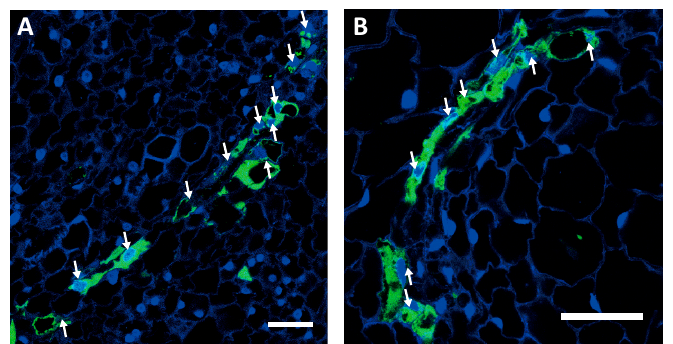
Figure 3. Green fluorescent protein (GFP)-conducting cells containing nuclei in the haustoria of ( A ) a 1.5-mm-diameter tubercle and ( B ) a 3-mm-diameter tubercle. White arrows indicate nuclei. Most of the GFP-conducting cells contained nuclei. Scale bar: 50 µ m.